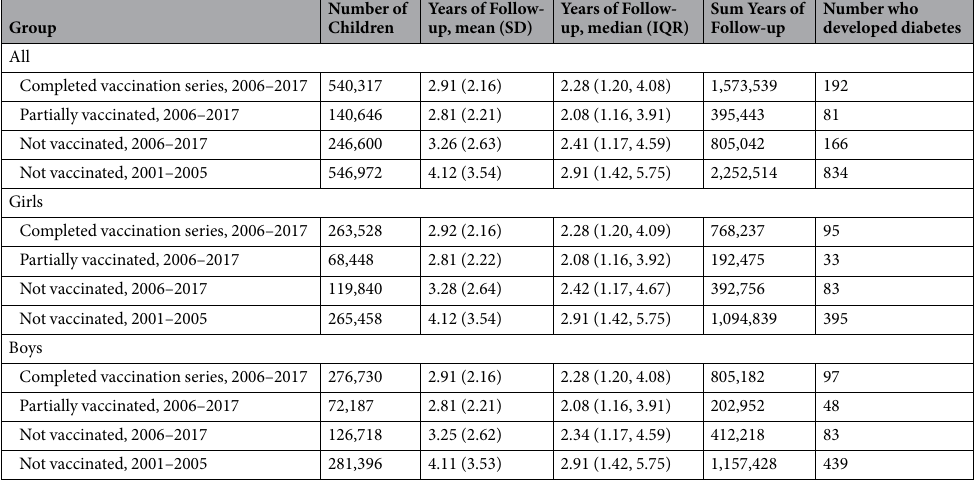
Table 1. Study Participants Stratified by Vaccination